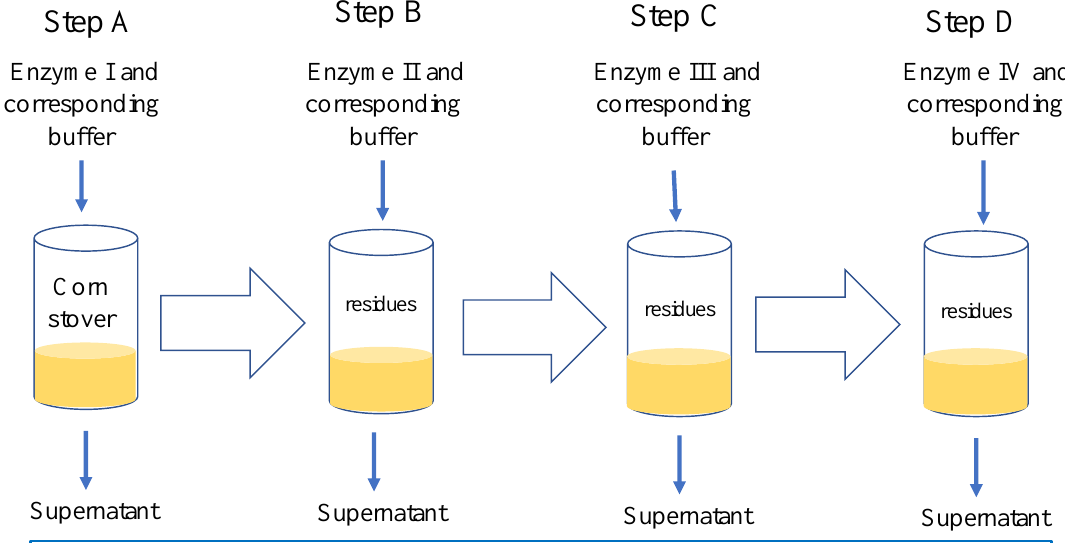
Figure 1. Example of one enzyme sequence.